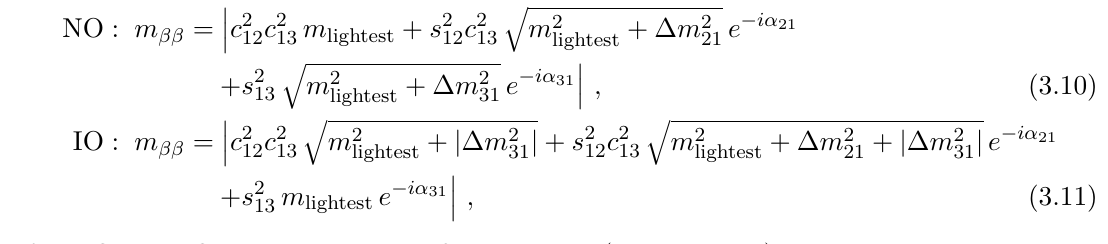
Figure 5 . Allowed regions in the ( m lightest , m ββ ) plane for NO (upper plots) and IO (lower plots). The presented colour scheme is the same as in figures 3 and 4. The dashed contours delimit the 1, 2 and 3 σ regions allowed by neutrino oscillation data only, without considering any extra constraint on M ν . The coloured vertical bars correspond to the upper-bound ranges on m ββ from EXO-200 [64], GERDA [65], CUORE [66] and KamLAND-Zen 400